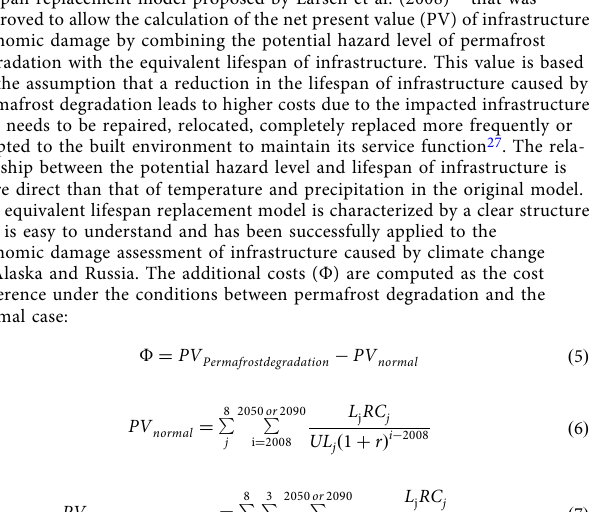
Table 3 The reduced proportion of the useful life of infrastructure due to permafrost